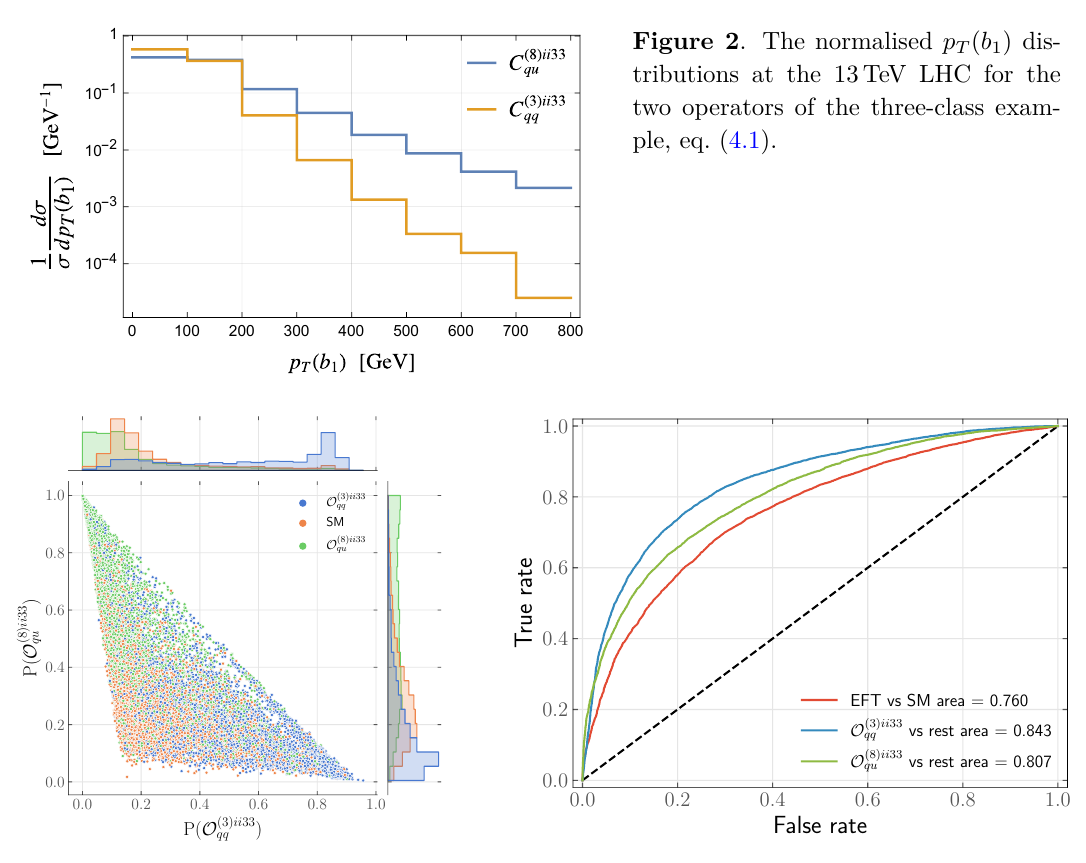
Figure 3 . The probabilities calculated for each event to be a result of each SMEFT insertion is shown. On the right the Receiver Operator Characteristic (ROC) curves are shown. We calculate these in a one-vs-rest scheme for each